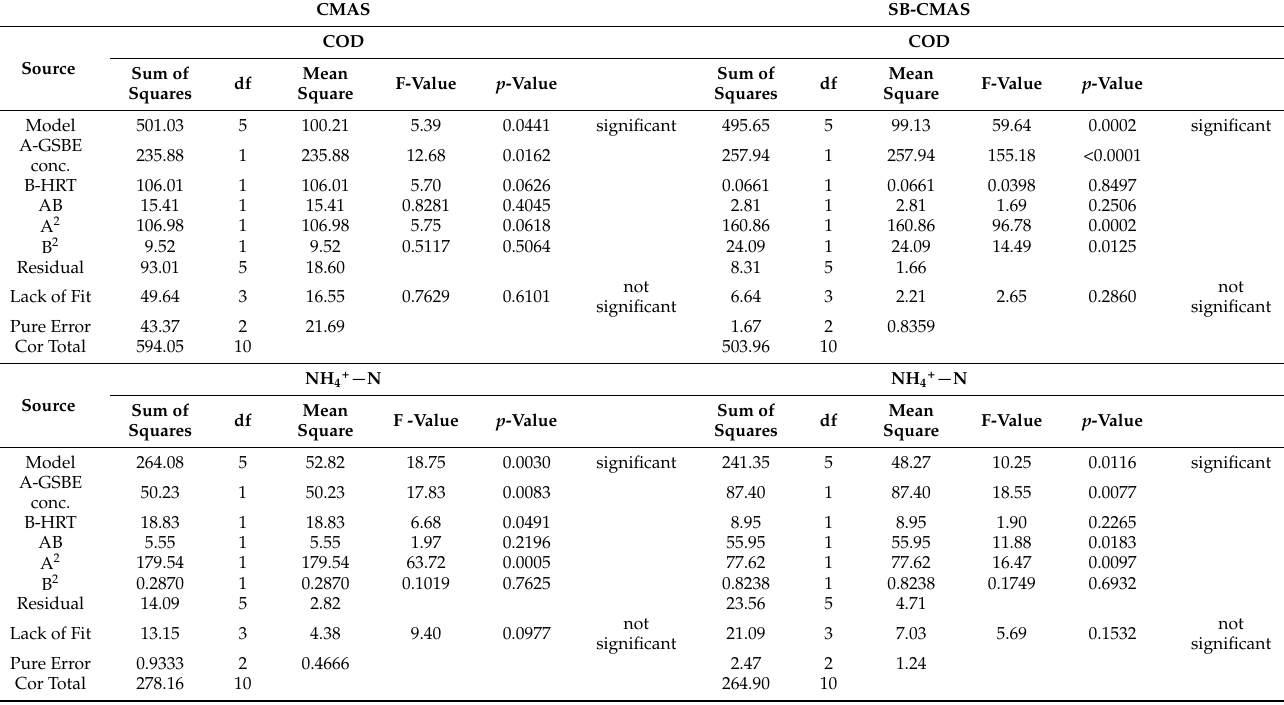
Table 5. Analysis of variance by RSM for COD and NH 4+ − N removal